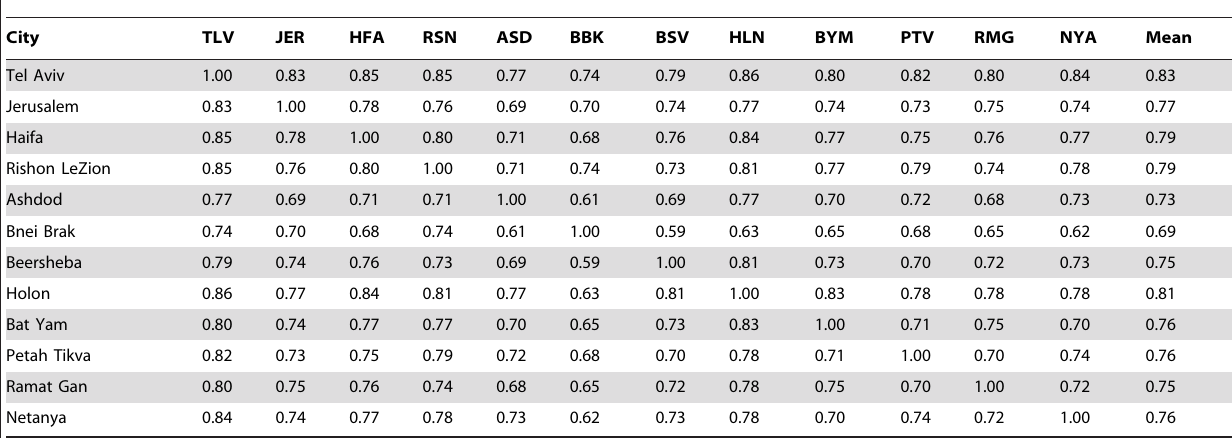
Table 4. Correlation matrix of daily incidence rates in all city pairs in 1998–2009.